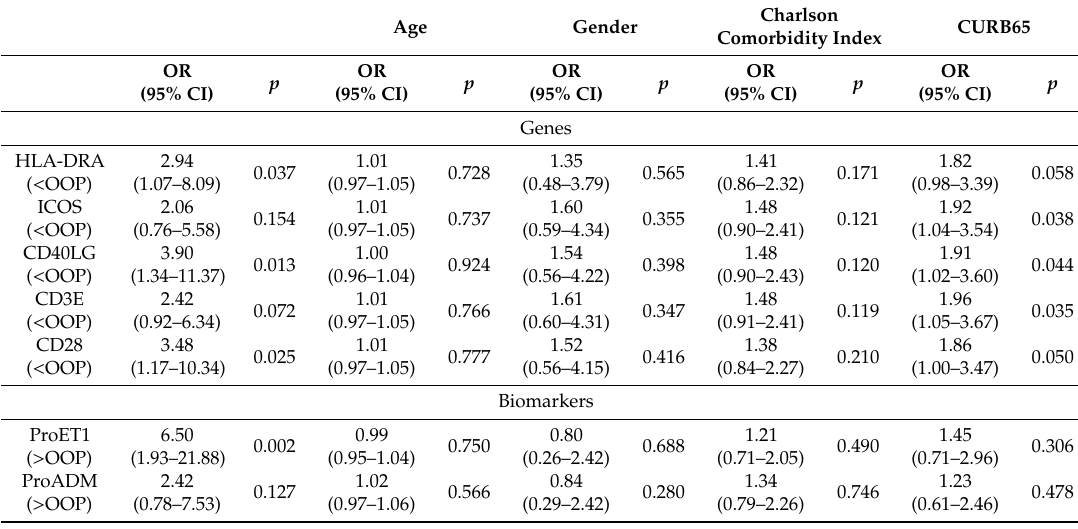
Table 5. Multivariable analysis evaluating the association between gene expression levels below each respective OOP and risk of presenting with organ failure / s adjusted for age, sex, Charlson comorbidity index, and